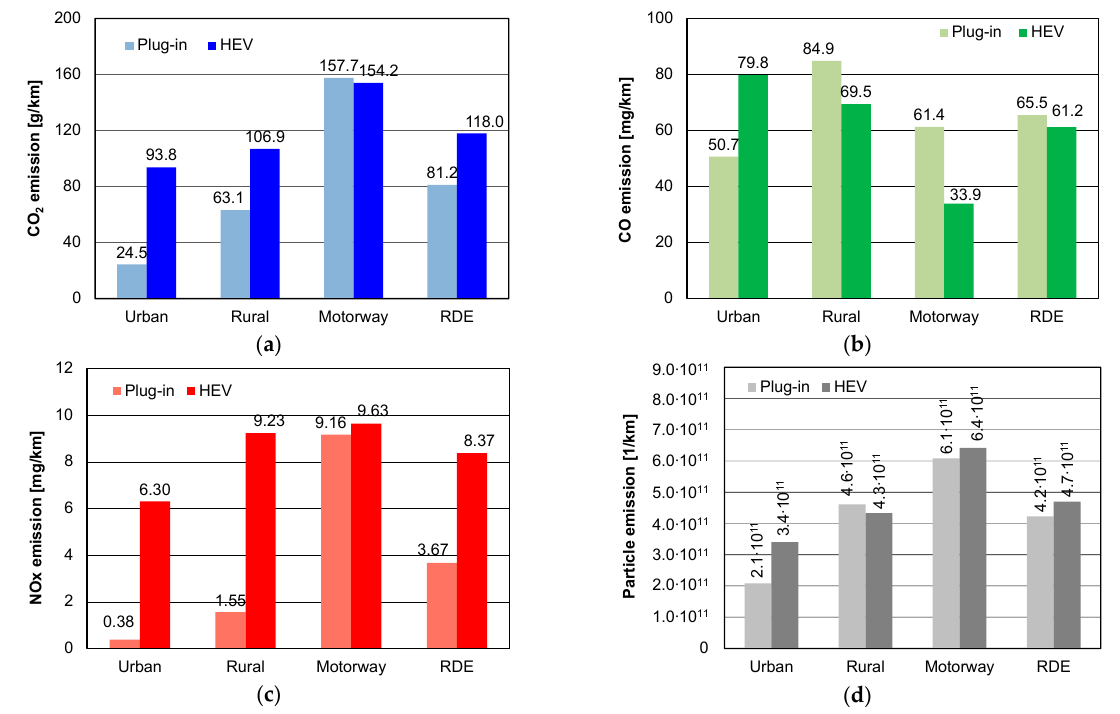
Figure 35. On-road emissions of plug-in and HEVs in the RDE test: ( a ) carbon dioxide, ( b ) carbon monoxide, ( c ) nitrogen oxides, and ( d ) particle number.